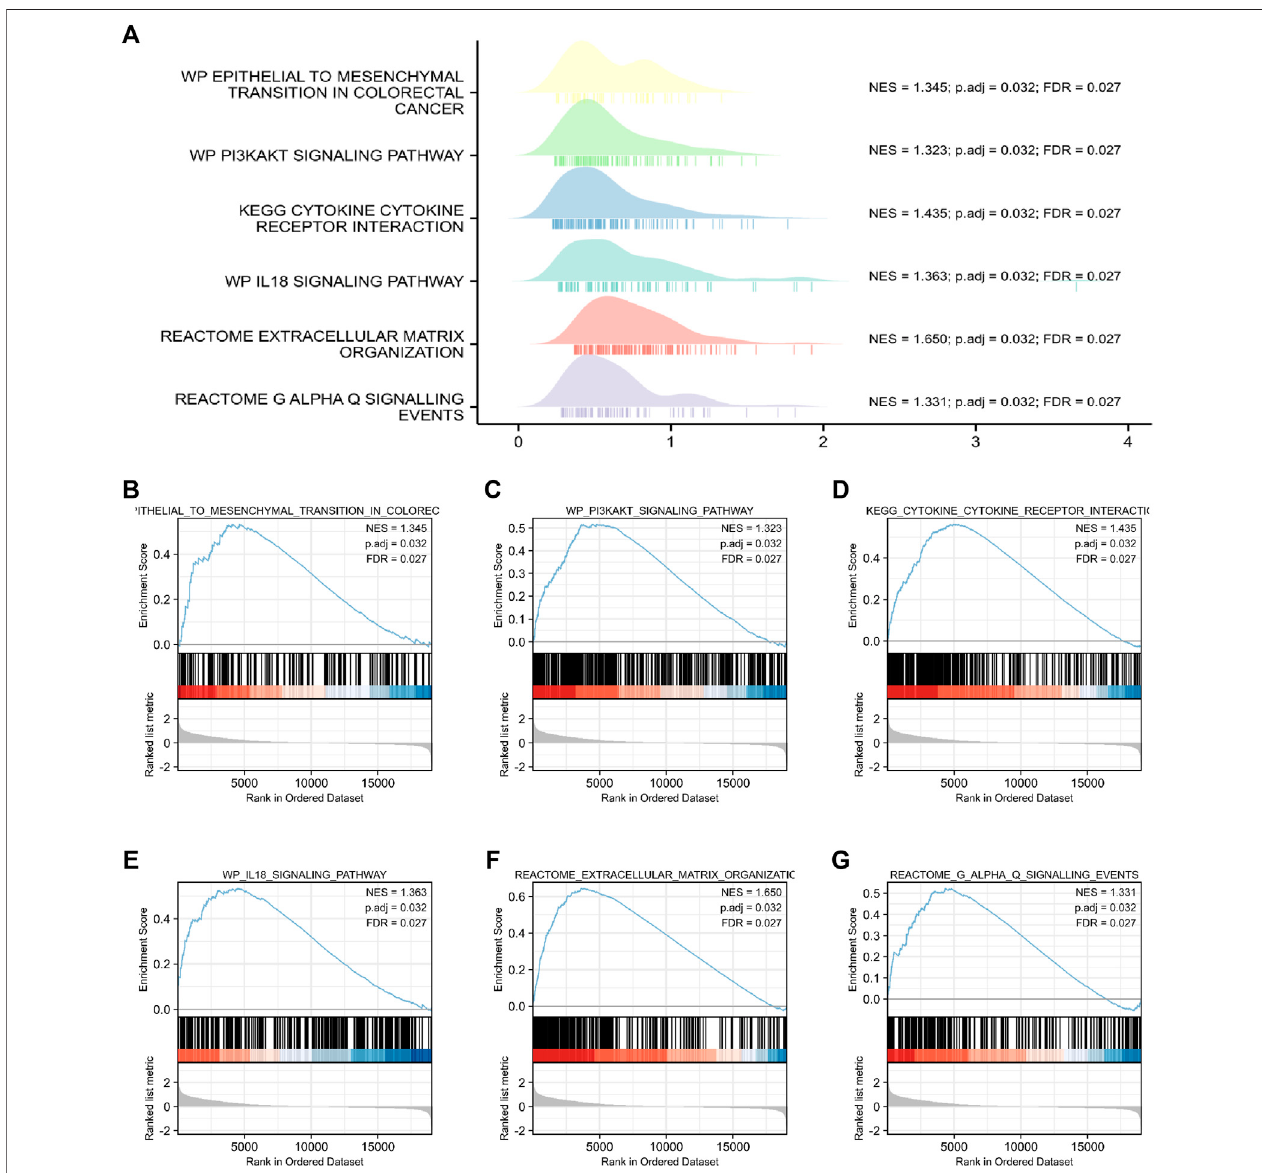
FIGURE 8 | Functional and pathway annotation among the high and low FCRLB groups by GSEA. (A – G) The GSEA revealed that EMT (B) , PI3K/Akt signaling pathway (C) , cytokine and cytokine receptor interaction (D) , IL-18 signaling pathway (E) , extracellular matrix organization (F) , Galphaq signaling (G) .